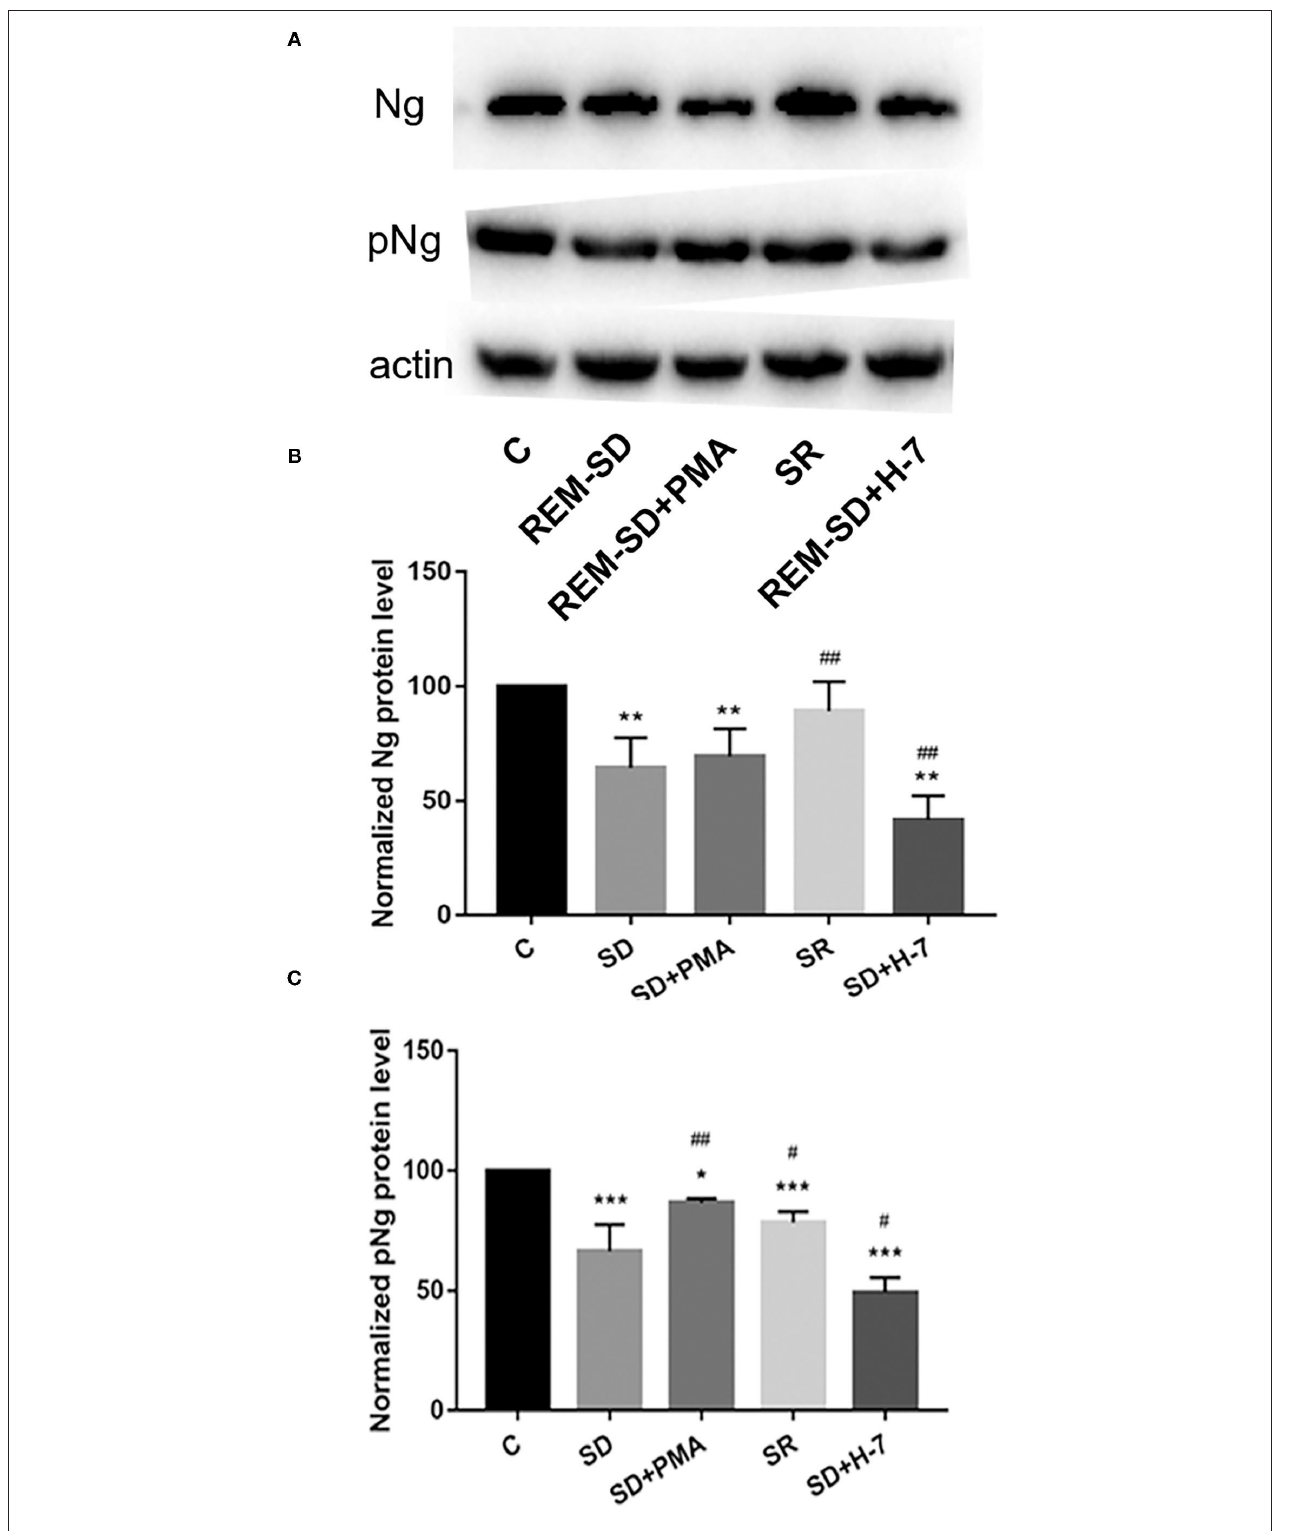
FIGURE 7 | Protein expression for Ng and phosphorylated Ng in the prefrontal cortex of SD rats from each group and control group (C). (A) Western blot analysis results. (B) Relative protein expression of Ng for each group. (C) Relative protein expression of phosphorylated Ng for each group. * P < 0.05, ** P < 0.01, *** P < 0.001 vs. control; # P < 0.05, ## P < 0.01 vs. SD